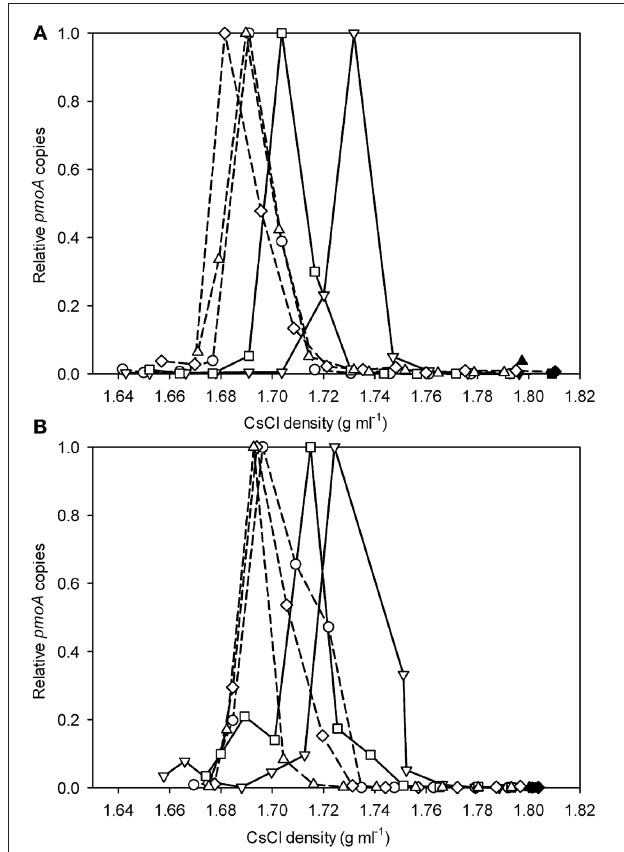
FIGURE 2 | Relative pmoA gene abundances recovered from CsCl gradient fractions for (A) TIK4 and (B) TIK5 after incubation with 13 CH 4 + 12 CO 2 ( (cid:3) ), 13 CH 4 + 13 CO 2 ( ∇ ), 12 CH 4 + 13 CO 2 ( (cid:2) ), 13 CO 2 ( (cid:3) ), and a control ( (cid:5) ). Solid lines represent incubations with 13 CO 2 and dashed lines represent incubations with 12 CO 2 . The y-axis indicates the relative abundance of pmoA genes recovered from each gradient fraction, with the highest quantity detected from a gradient fraction equal to 1.0. Points are averages of duplicate qPCR measurements. Experiments were performed in duplicate, one representative graph is shown as duplicate experiments showed similar results.